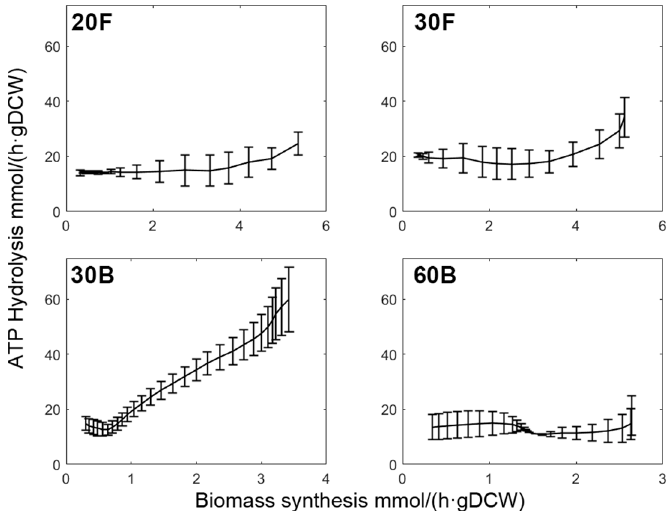
Figure 8. Flux profiles of ATP hydrolysis vs. the rate of non-PHB biomass synthesis.